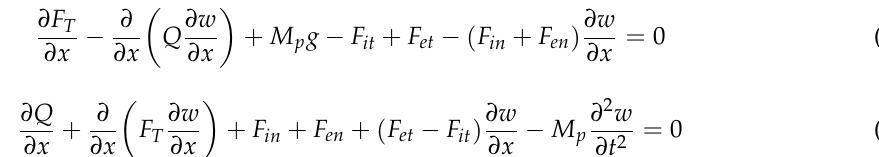
Figure 3. Excessive bending of the inner tubing at a Chinese salt cavern storage [3].